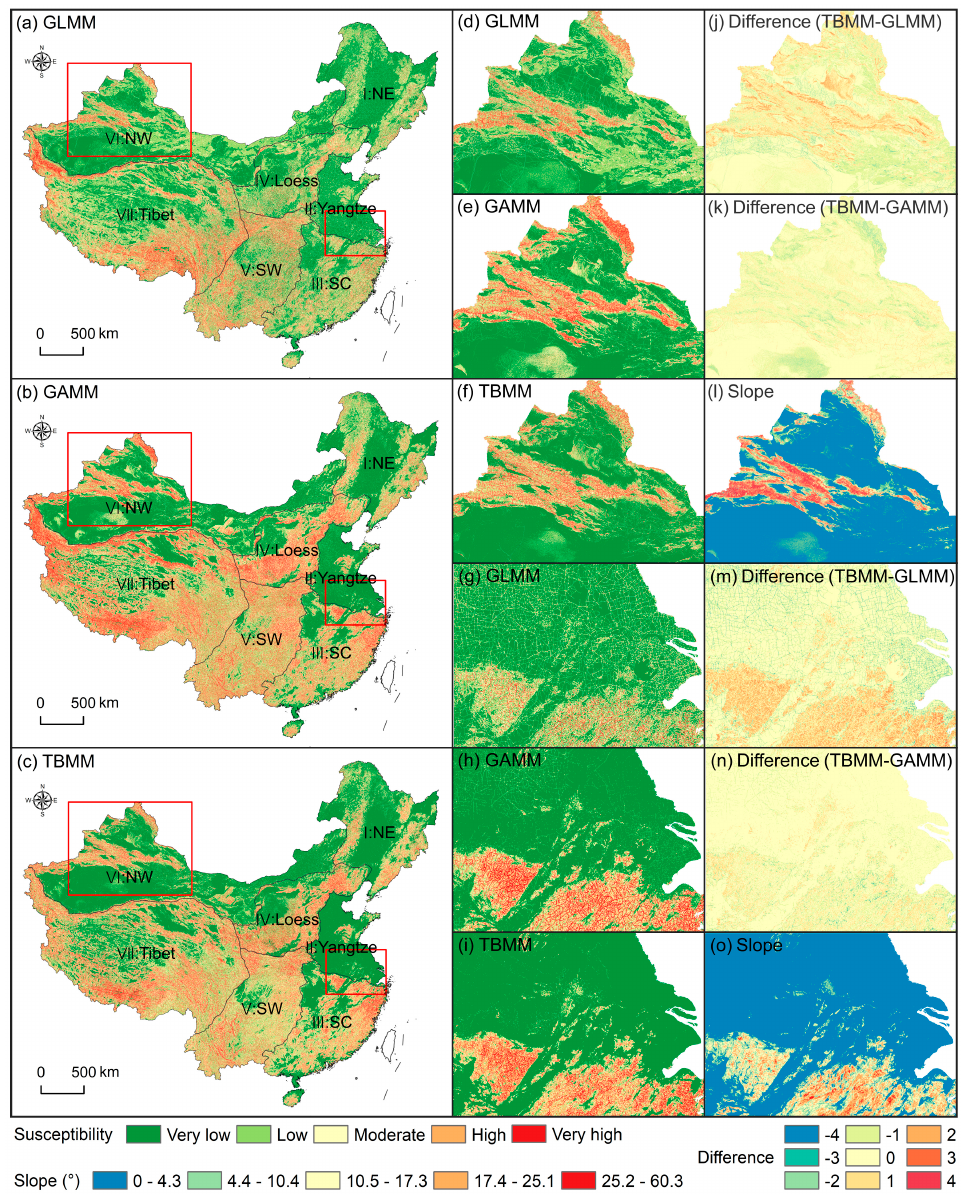
Figure 8. Debris flow susceptibility maps. ( a–i ) Susceptibility maps for China and local areas yield by three mixed models; ( j,k,m , n ) the difference between TBMM and other models in local areas; ( l,o ) the topography slope in local areas.